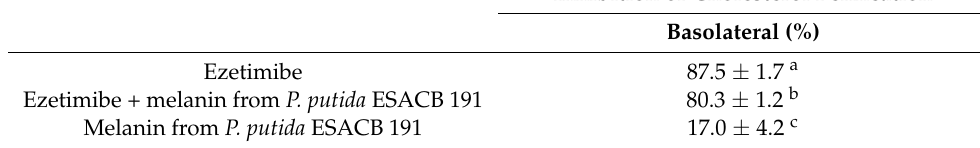
Table 4. Pseudomonas putida ESACB 191 melanin (1 mg/mL) and pharmaceutical compound ezetimibe (100 µ M) in the inhibition of cholesterol (5 mM) permeation. The standard deviation values were calculated based on three replicates for each condition; different superscript letters (a, b, c) correspond to values in the same assay condition that can be considered statistically different (95% confidence level). (-) not